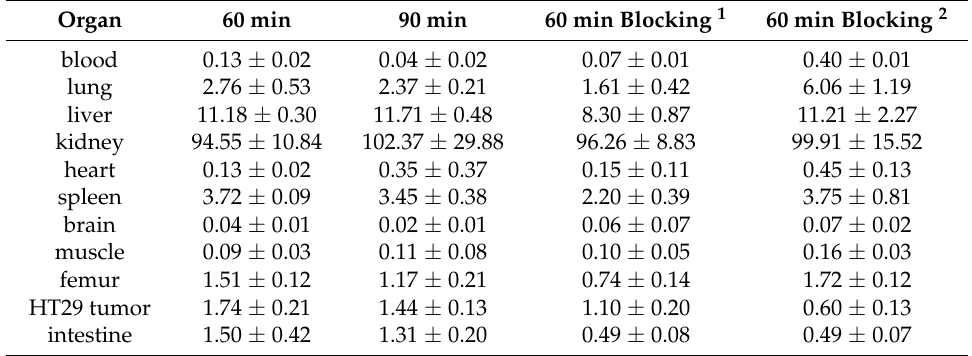
Table 2. Biodistribution data of [ 68 Ga]Ga-TRAP(NT4) 3 expressed as percent injected dose per gram tissue (%ID/g) ± standard deviation of 2–3 HT29 tumor-bearing nude mice for each time point.